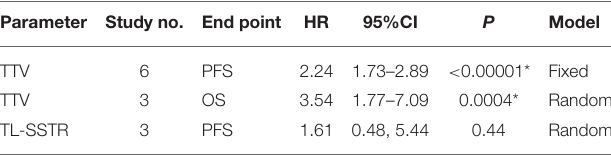
TABLE 2 | Summary of the meta-analysis results.